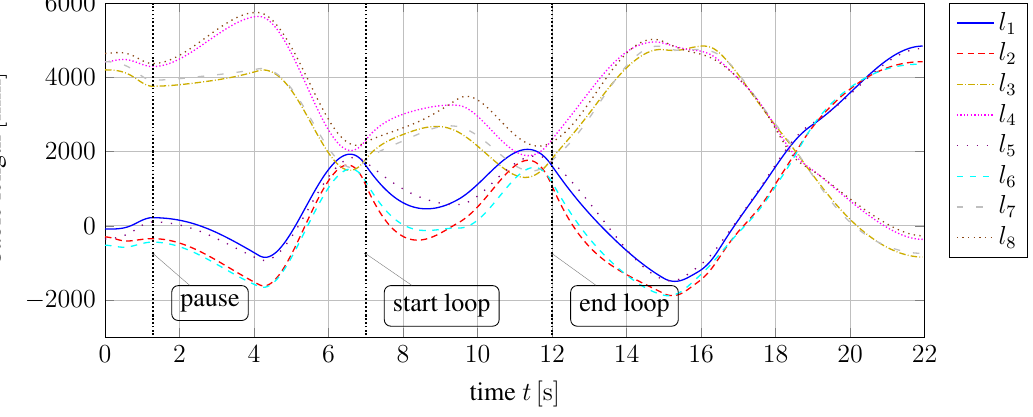
Figure 9. Cable length l i .